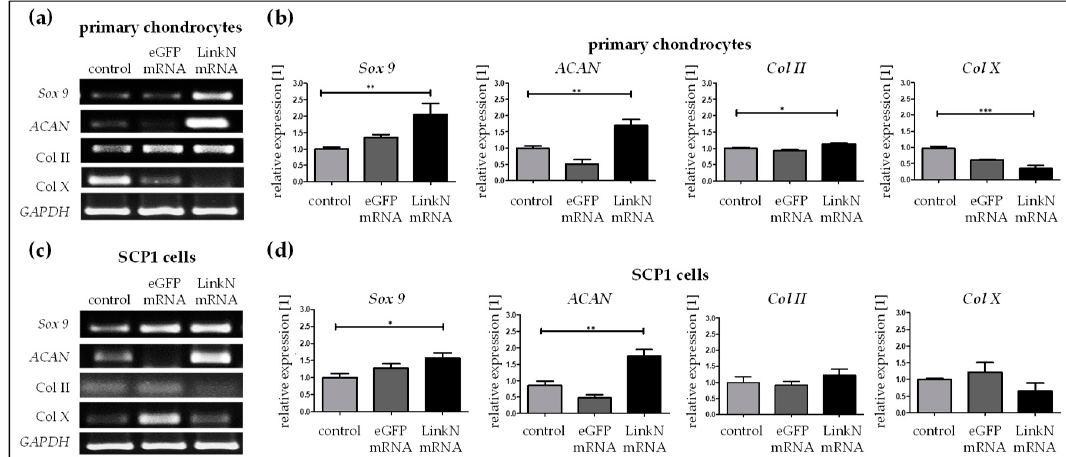
Figure 8. The effect of Link N mRNA transfection on cells seeded on knitted titanium scaffold- changes in ACAN , Sox 9 , Col II and Col X gene expression. Primary human chondrocytes or SCP1 cells (1 × 10 5 ) were transfected with 1 µ g of Link N mRNA, and the influence on ECM-related genes and chondrocyte anabolic markers was investigated. Representative gel images evaluating the changes in ACAN , Sox 9 , Col II and Col X gene expression 24 h after Link N mRNA transfection in ( a ) human primary chondrocytes and ( c ) SCP1 cells. Gene expression were examined 24 h after Link N mRNA transfection in ( b ) human primary chondrocytes and ( d ) SCP1 cells seeded on knitted titanium scaffolds using semi-quantitative RT-PCR. Cells treated with Lipofectamine 2000and eGFP mRNA transfected cells were used as controls. GAPDH was used as an internal control and served to normalize the expression. Relative expression levels obtained by densitometric analyses are represented as mean ± SEM (N ≥ 3), and were compared using one-way ANOVA with Bonferroni’s multiple comparison test (*** p < 0.001, ** p < 0.01, * p < 0.05).